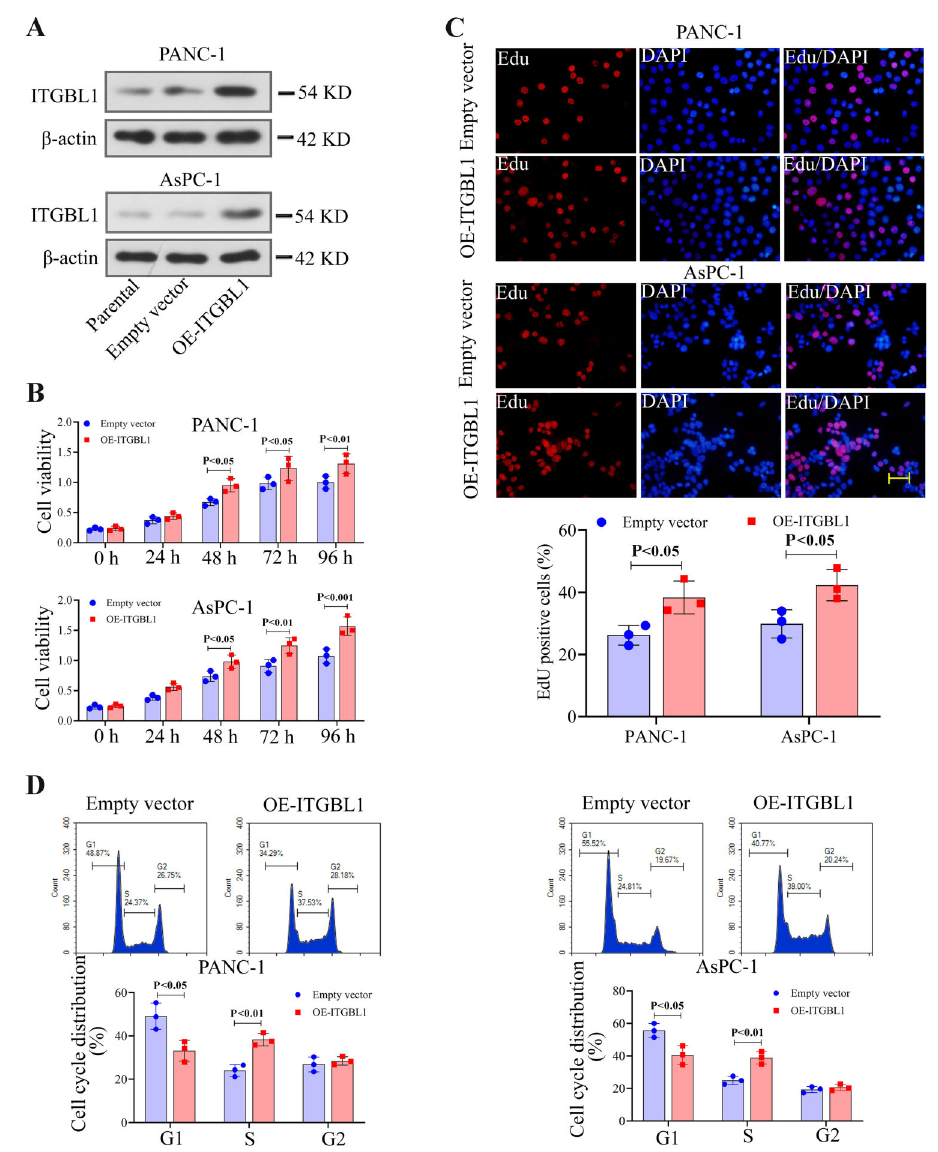
Figure 2. ITGBL1 overexpression (OE-ITGBL1) promoted the proliferation of pancreatic cancer cells. A , Relative ITGBL1 protein expression, standardized by b -actin, in ITGBL1-overexpressed cells was performed by western blot. B , Cell viability of pancreatic cancer cells with ITGBL1 overexpression was detected by MTT assay. C , EdU assay was performed on pancreatic cancer cells with ITGBL1 upregulation. Scale bar=50 m m. D , Cell cycle distribution of ITGBL1-overexpressed cells was measured by a fl ow cytometer. Data are reported as means ± SD for N=3 ( t